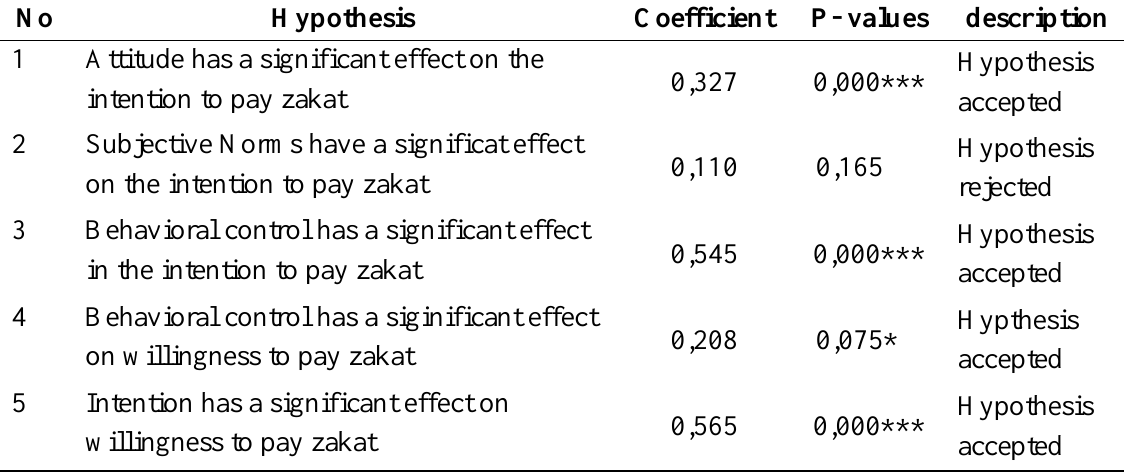
Table 8: Hypothesis Test